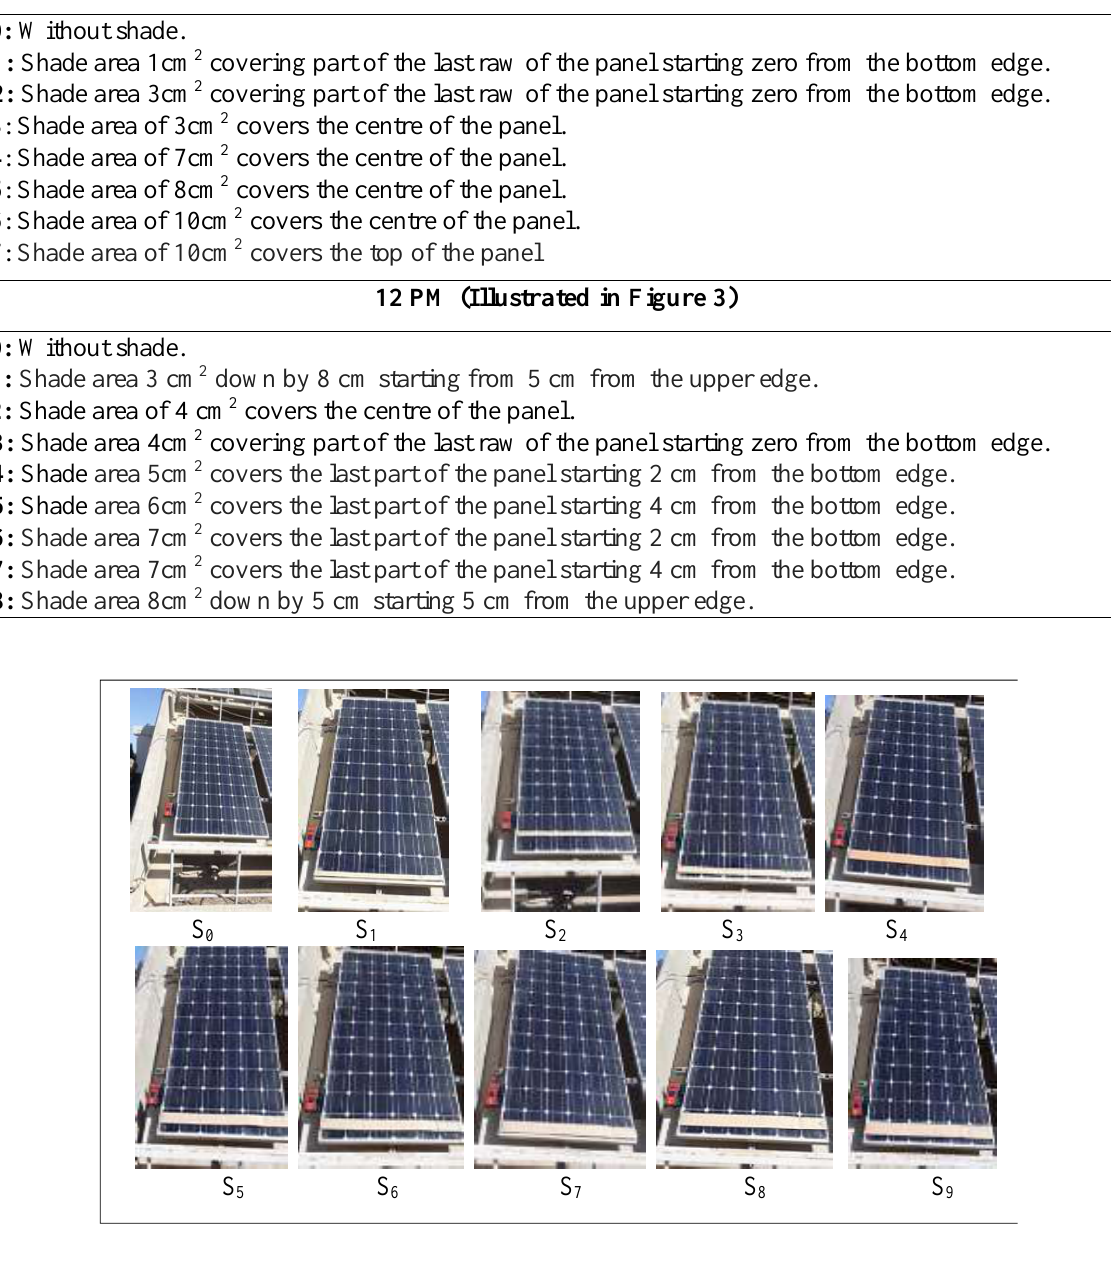
Figure 1. Photos of the shade at 8:30 AM.